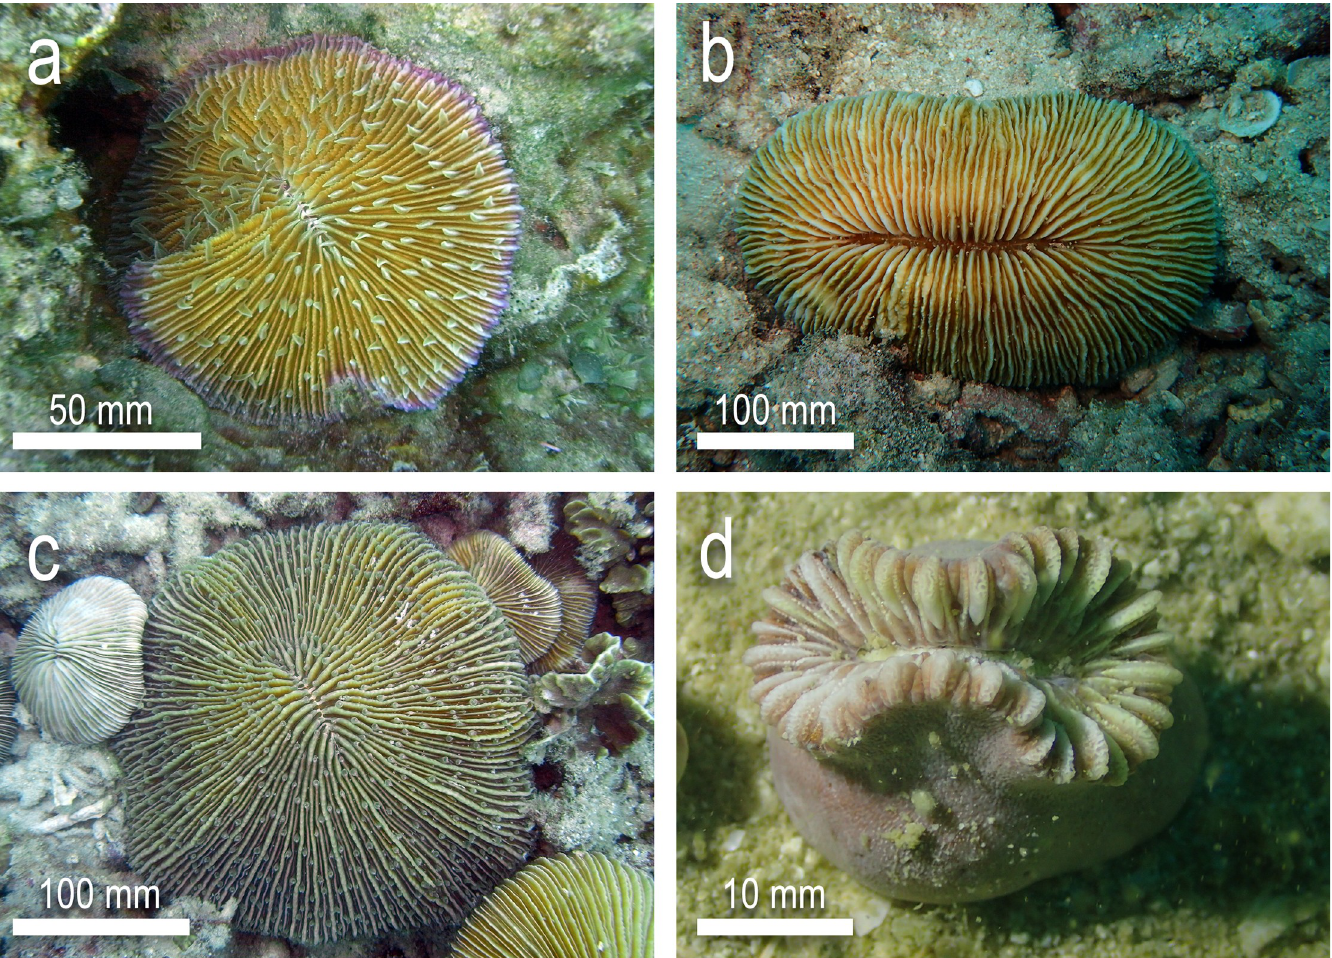
Fig 2. Predator corals tested for consumption of slugs. a) Fungia fungites b) Pleuractis paumotensis c) Danafungia scruposa d) Heteropsammia cochlea